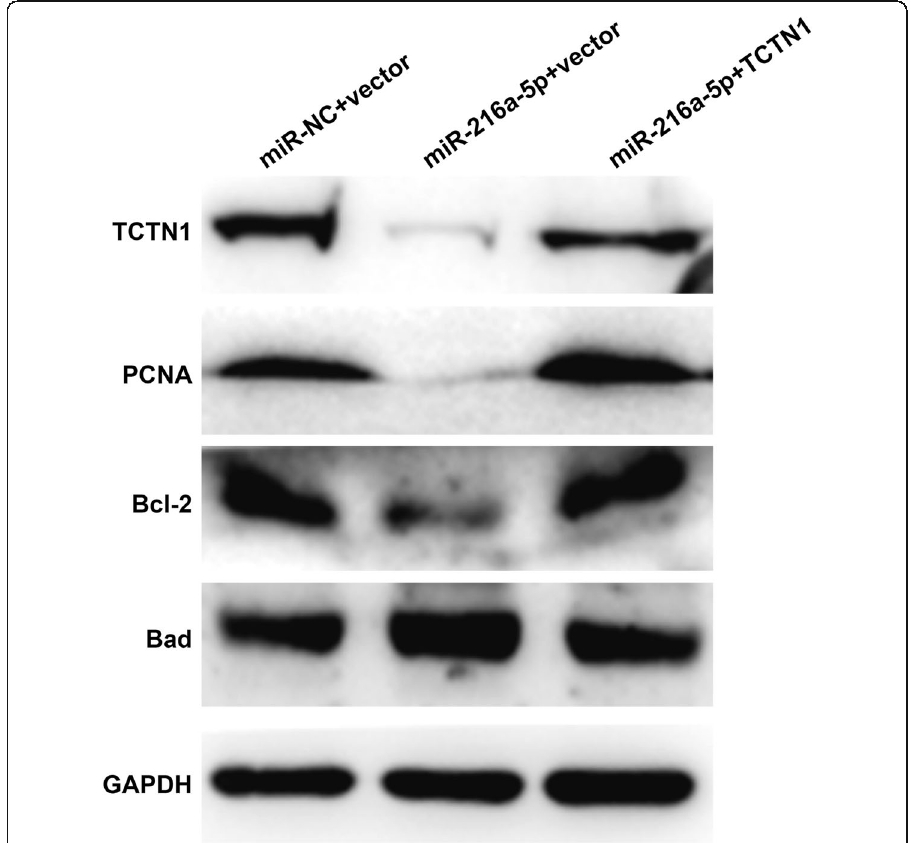
Fig. 6 Addition of TCTN1 reversed the regulation of miR-216a-5p on the proliferation and apoptotic markers in ESCC. EC9706 cells were co-transfected with miR-216a-5p mimic/miR-NC and with TCTN1 overexpression plasmid/empty vector. Western blot analysis was performed to analyze the expression of PCNA, Bcl-2 and Bad in EC9706